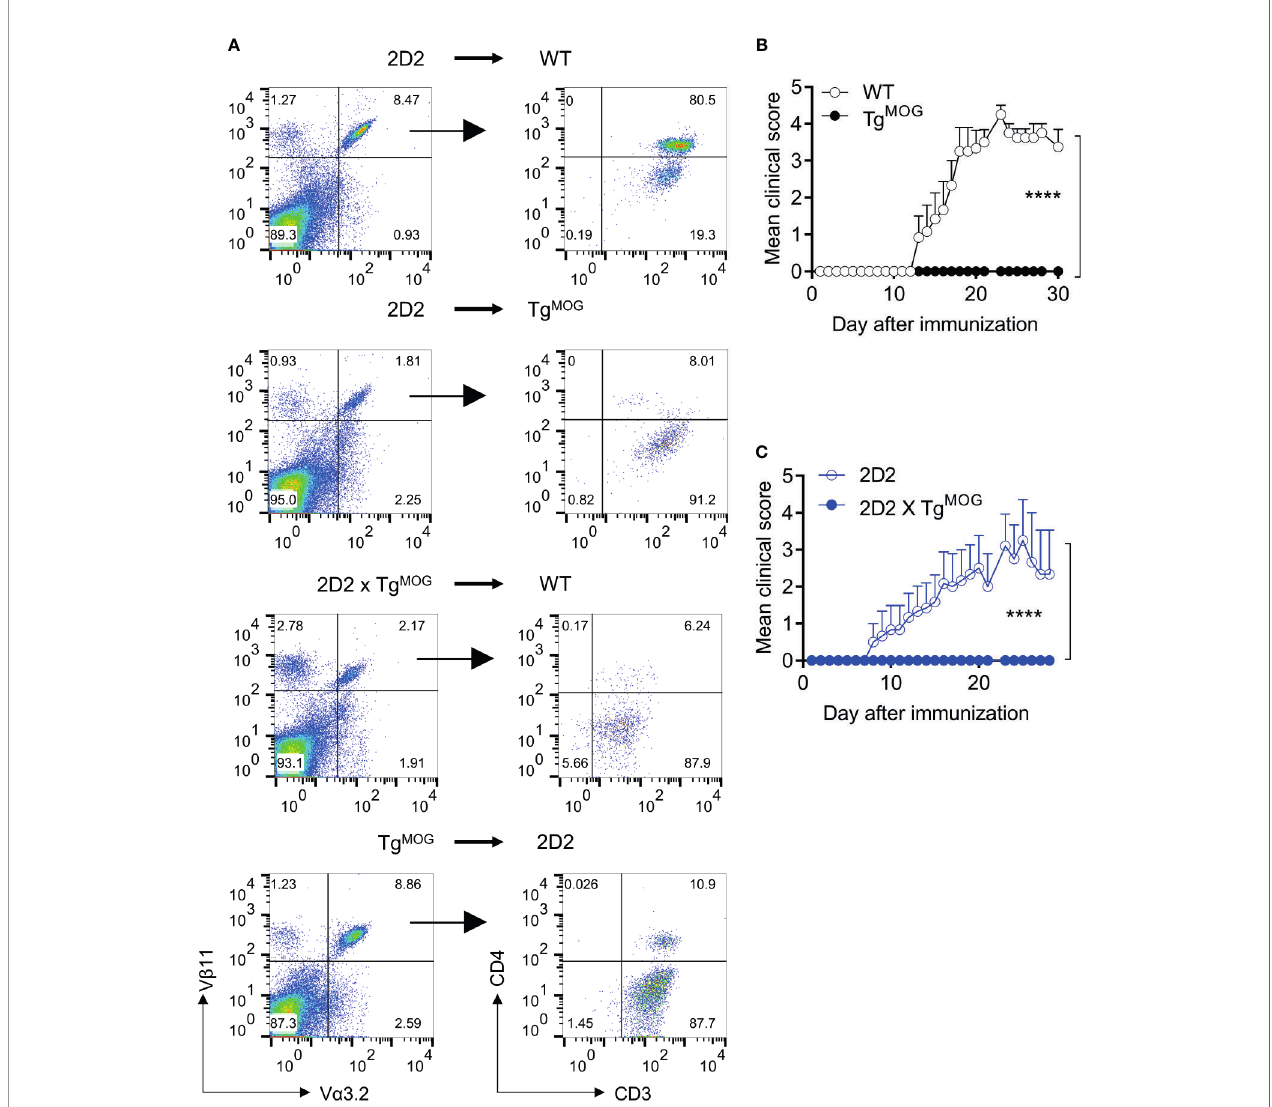
FIGURE 6 | MOG expression in immune organs induces T cell tolerance and suppresses EAE. (A) , Analysis of CD4 and CD3 expression in transgenic TCR V a 3.2 + V b 11 + cells after bone marrow transplantation. Representative plots are shown. (B) , Mean EAE clinical scores in WT (n = 6) or Tg MOG (n = 6) mice immunized with MOG 35-55 . (C) , Mean EAE clinical scores in 2D2 (n = 6) or 2D2 X Tg MOG (n = 4) mice immunized with MOG 35-55 . (B, C), Representative data from two independent experiments is shown. ****P < 0.0001 (Two-way